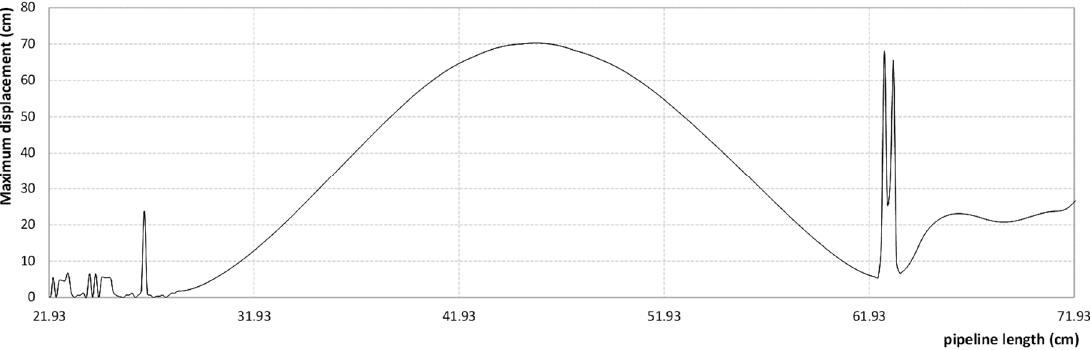
Figure 6. Maximum displacement in each point of the pipeline during a transient event.